Question: Name the type of graph shown.
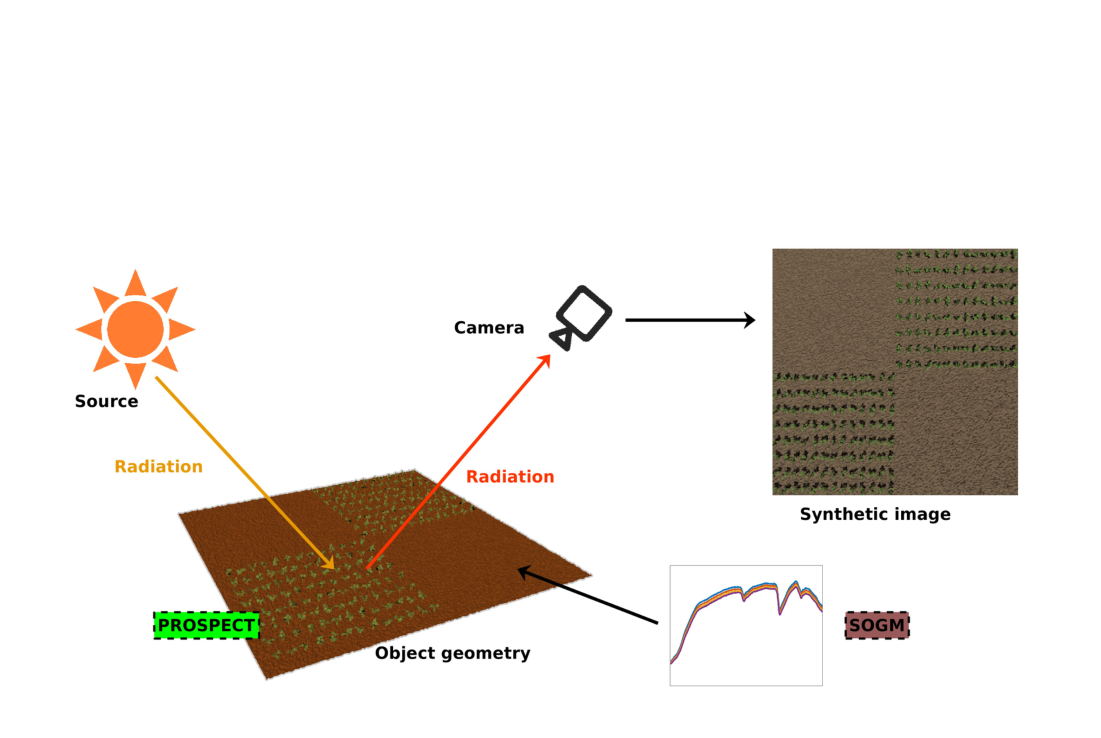
Answer: scatter